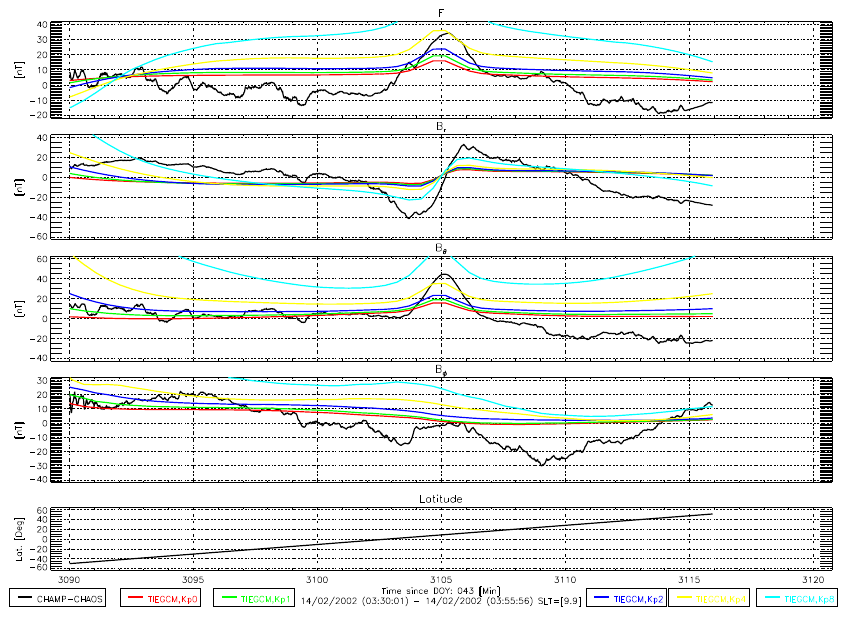
Fig. 7. The residual and TIE-GCM perturbation prediction data along a satellite orbit track for one dayside orbit pass on 14 February 2002 between ± 50 ◦ latitude in units of nT comparing the effects of varying K p . The bottom axis is time (minutes) since the start of the modeling run, in this case 12 February 2002. The plot windows correspond to (a) the total field perturbation, (b) the B r component of the perturbation, (c) the B θ component, (d) the B φ component, and (e) the satellite latitude (in degrees). A constant F 10 . 7 of 190 is used with either K p = 0 (red), K p = 1 (green), K p = 2 (blue), K p = 4 (yellow), K p = 8 (cyan), and CHAMP/CHAOS residual